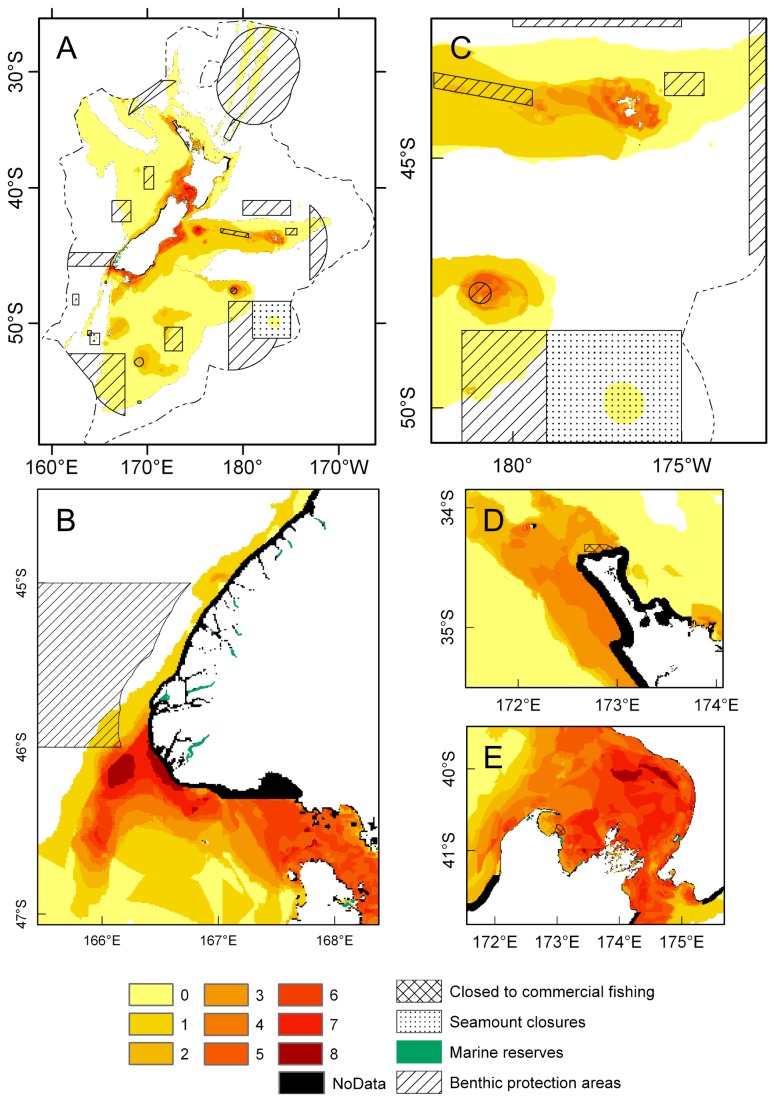
Protected seafloor in New Zealand.The spatial relationship between predicted bryozoan hotspots and areas closed to commercial fishing (no trawl, Danish seine or commercial dredge (amateur dredge allowed)), seamount closures, marine reserves/marine protected areas, and benthic protection areas in the New Zealand: A) across the Extended Continental Shelf; B) west of Fiordland (south-west South Island); C) on the eastern Chatham Rise, and around Chatham, Bounty and Antipodes Islands; D) off northern North Island; and E off northern South Island. Cells for which data in one or more environmental layer were missing are black.